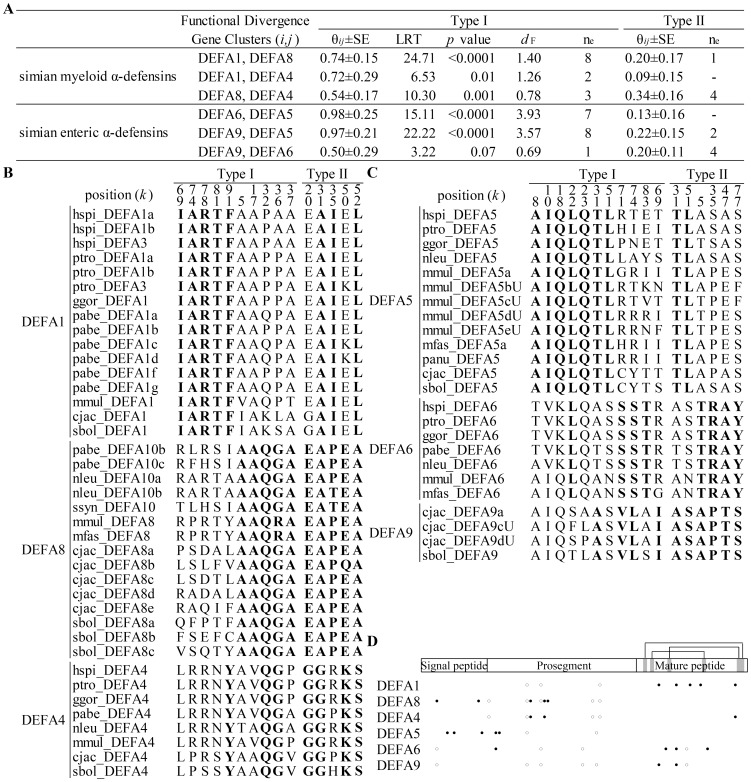
Type I and type II functional divergences among simian enteric or myeloid α-defensin clusters.A: Statistical analyses of the type I and type II functional divergences. Clusters within both simian enteric α-defensins and simian myeloid α-defensins have diverged. Pairwise coefficients (θij±SE) and likelihood ratio statistics (LRT) are analyzed using the bootstrapped Gu99 method. Type I functional distance (d
F) between clusters is calculated as d
F = −ln(1−θij). The effective number of functional divergence related sites (ne) is estimated following the Gu2013 method. B: Critical amino acid sites responsible for type I and type II functional divergences from simian myeloid α-defensin clusters. These sites are identified based on the ne cutoff after ranking posterior probabilities. C: Critical amino acid sites responsible for type I and type II functional divergences from simian enteric α-defensin clusters. D: The diagram of the sites responsible for type I and type II functional divergences in different simian clusters. Closed circles represent sites responsible for type I functional divergence, and opened circles denote sites responsible for type II functional divergence.